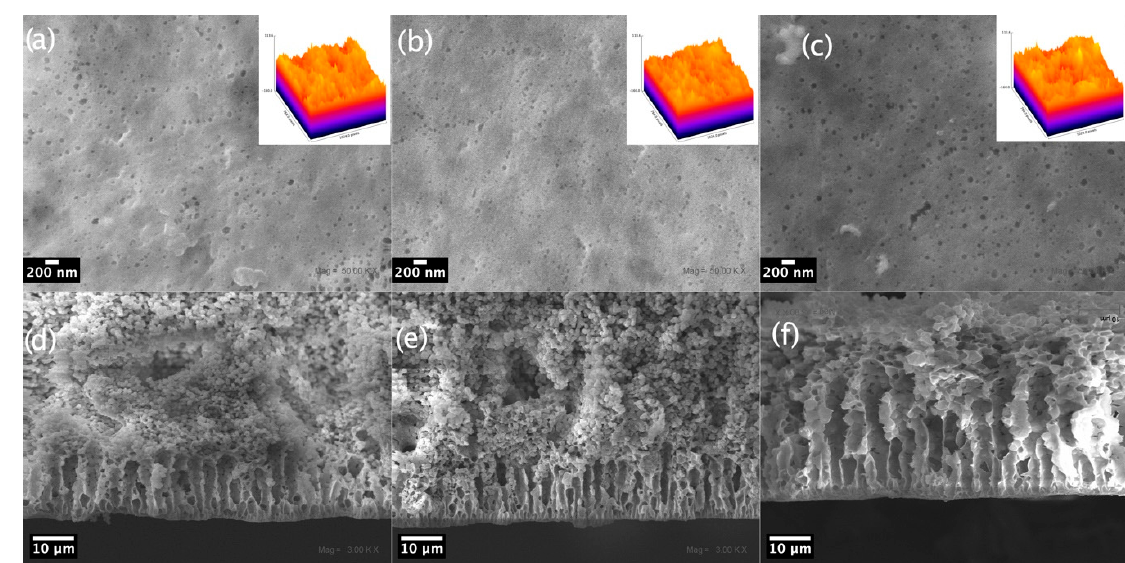
Figure 5. Surface ( a – c ) and cross-section ( d – f ) SEM micrograph images of PVDF composite membranes prepared at 2% ( a , d ), 5% ( b , e ), and 10% ( c , f ) CuONPs. The insets in the upper row show 3D color surface roughness profiles (x = 768 px; y = 1024 px; z (intensity): − 160 to 113)).